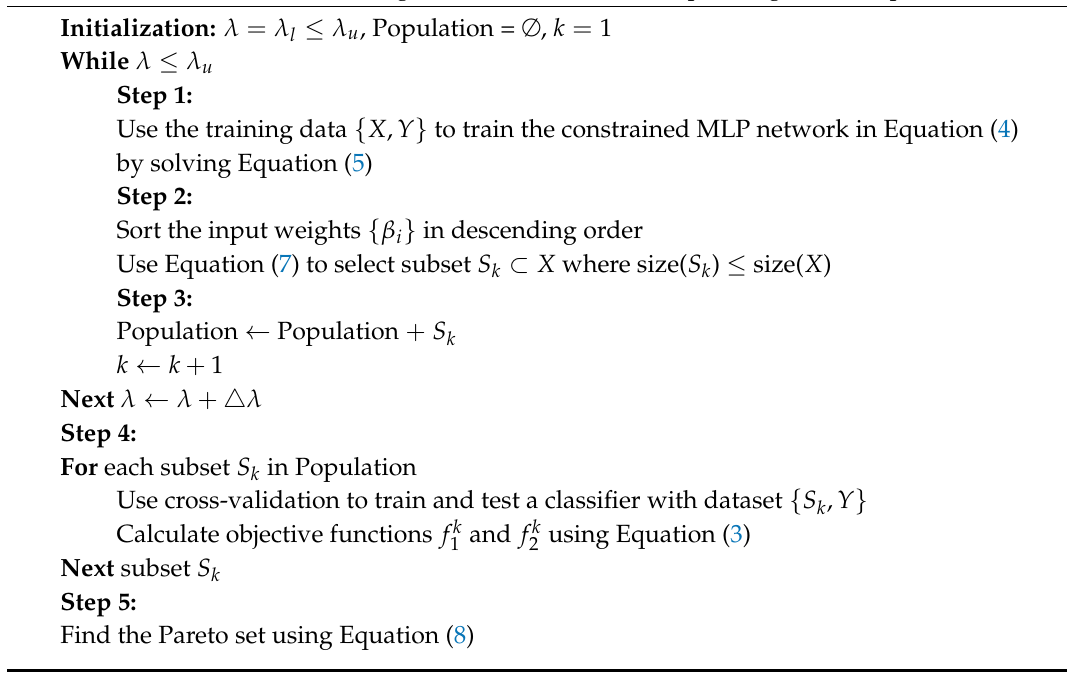
Algorithm 1: The outline of gradient-based multi-objective feature selection (GMOFS), where x i is the i -th feature in the training set X , and Y is the corresponding set of output